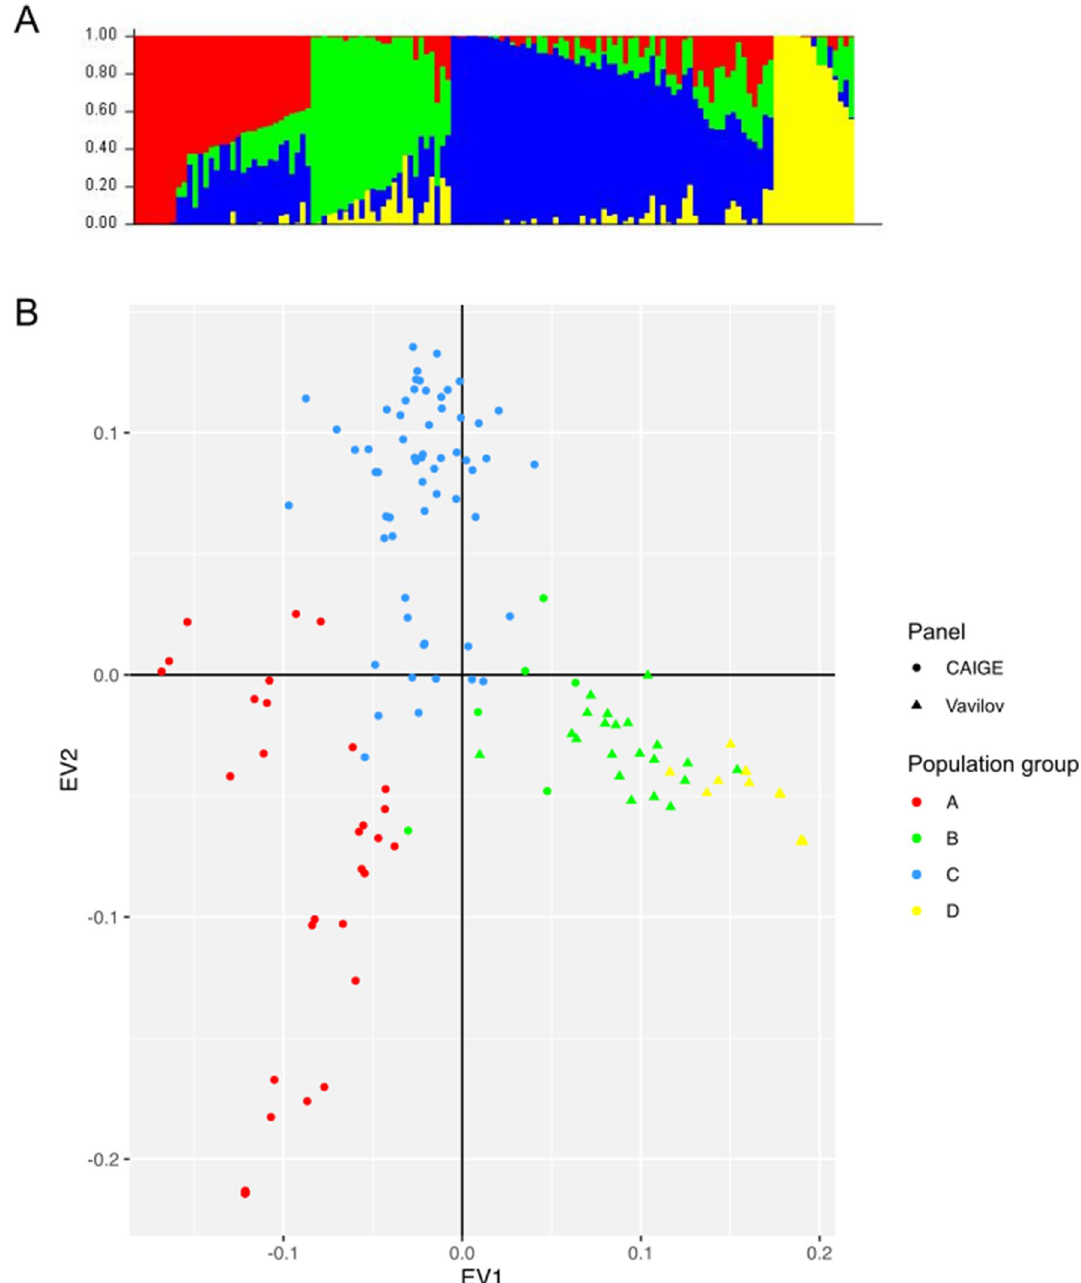
Figure 2. Principal component analysis of 134 wheat lines based on a ~ 6500 SNP. ( A ) STRU CTU RE analysis with the optimal K value of 4. ( B ) Lines in the PCA plot are colour-coded according to the grouping. ( A ) was produced by a built-in function in STRU CTU RE, ( B ) was created by using ggplot2 version 3.3.3 (2020-12-30) in R 43